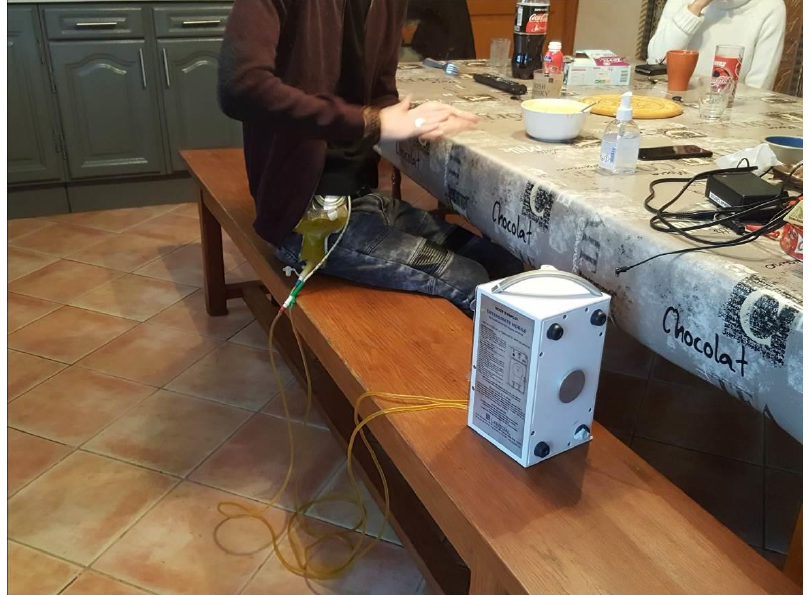
Figure 6. Male, 21 years old, hospitalization 27 days, CR at home 153 days.